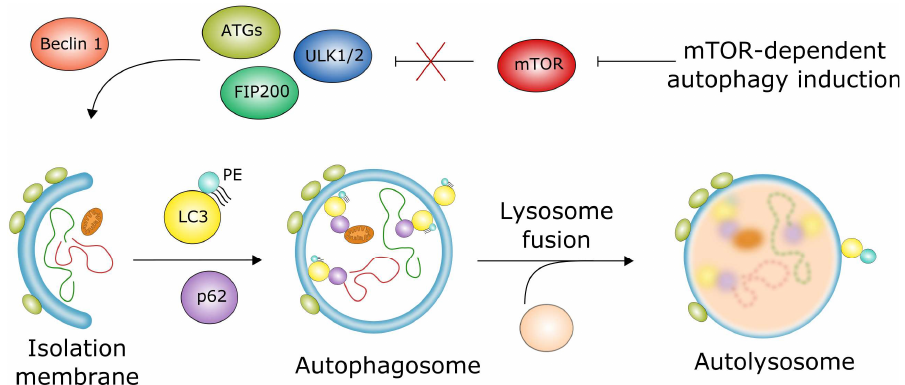
Figure 6. Macroautophagy dependent on mTOR (mammalian target of rapamycin) can be induced by a lack of nutrients, which leads to the activation of the ULK1 complex, containing UKL1/2, FIP200, ATG13, and ATG101, that is inhibited by the mTOR complex in normal conditions. This complex, with the involvement of Beclin 1, supports the formation of an isolation membrane (phagophore), which encircles the cargo, consisting of damaged and no longer needed cellular components, to form an autophagosome, a double-membrane vehicle which encloses the cargo. The process of autophagosome formation is mediated by several proteins, including LC3, and p62 (SQSTM1), which are essential for autophagy, and involves phospholipids, including phosphatidylethanoamine (PE). The autophagosome fuses with the lysosome forming the autolysosome, in which degradation and recycling of the cargo occurs. Sharp arrows denote stimulation/induction, while blunt arrows: inhibition/downregulation; an X mark denotes abolishing of the inhibitory action of mTOR.